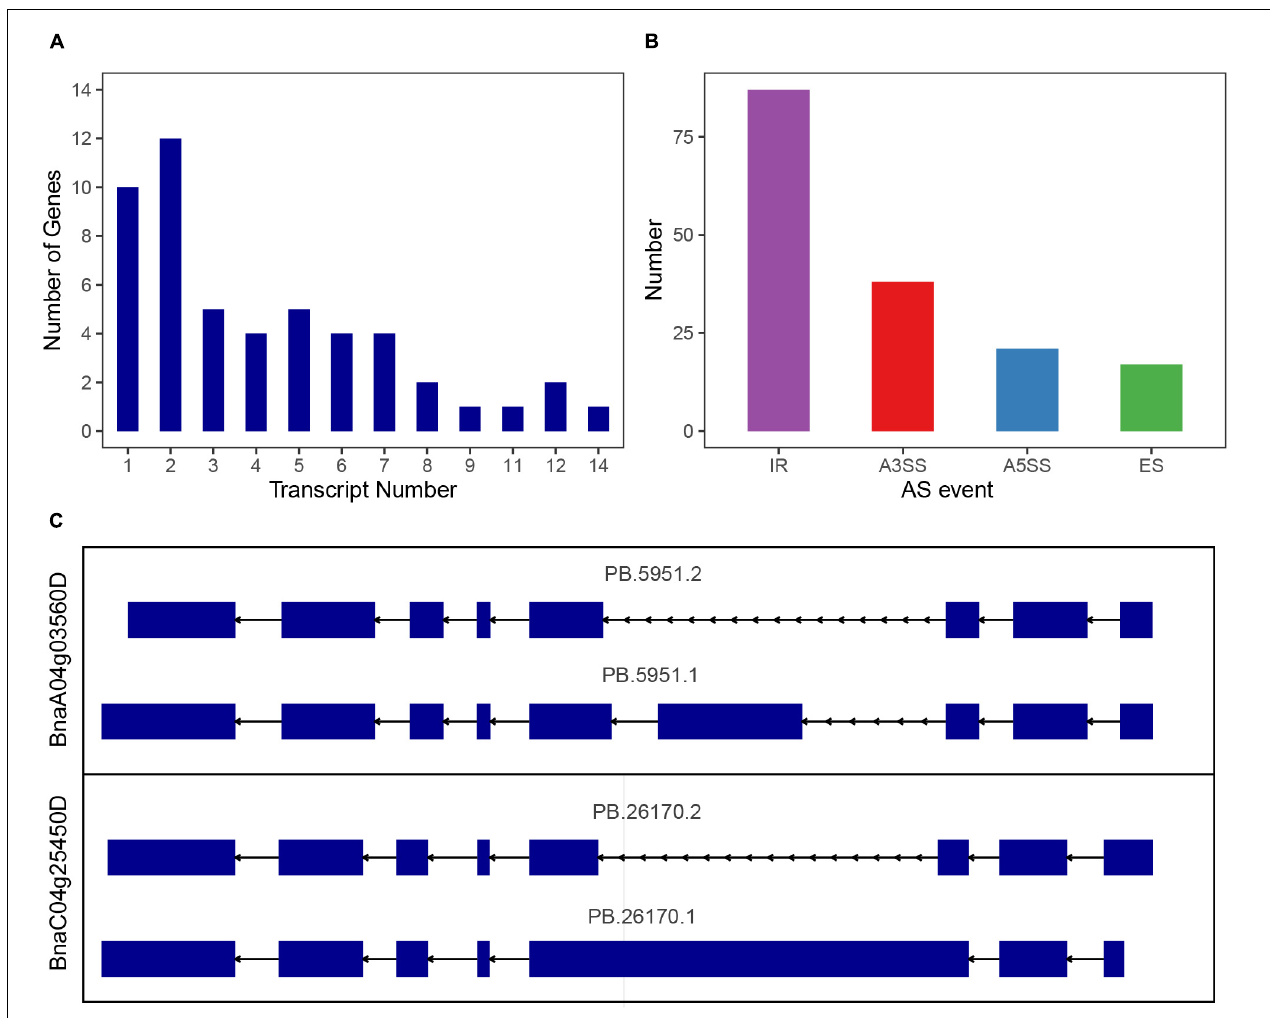
FIGURE 9 | Splicing profiles of SR genes in B. napus based on Iso-Seq data. (A) The numbers of SR genes that produced one or more transcripts from Iso-Seq data. (B) Classification of AS events. IR, intron retention; A3SS, alternative 3 (cid:48) splice site; A5SS, alternative 5 (cid:48) splice site; ES, exon skipping. (C) Different splicing patterns of a paralogous gene